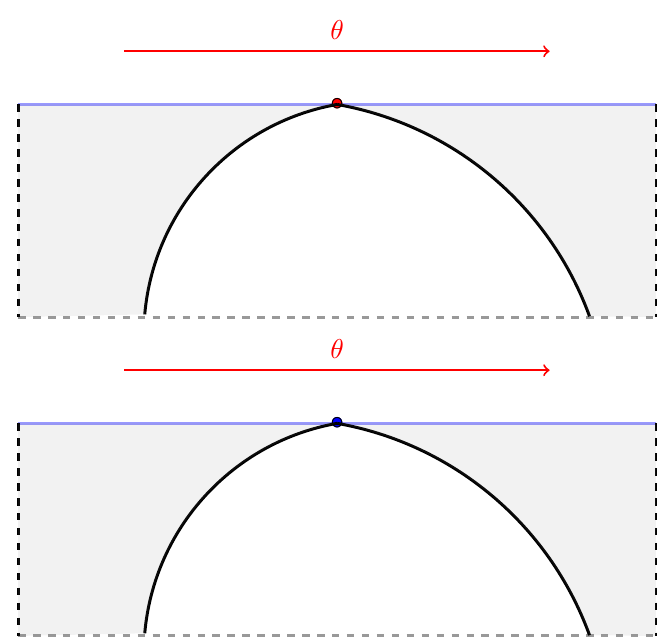
Figure 5. A typical brane configuration on a constant time t = t 0 slice on different sides of a bulk maximally extended BTZ black hole eq. (3.12). The red and dark blue dots are the defects on each side and they are in a thermofield double state. The blue lines are the conformal boundary which goes from 0 to 2 π in θ , the black curves are the two Karch-Randall branes, the dashed black horizontal lines are the black hole horizon r = r h and the shaded regions are removed (we assume brane tension positive). The whole geometry should be identified along the two vertical black dashed lines on each diagram. We neglect the parts of the branes behind the black hole horizon which are easily seen to be